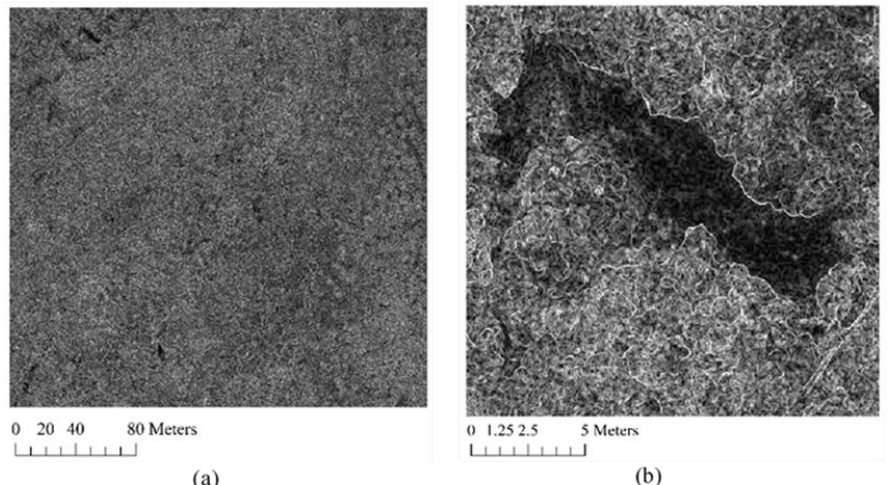
Figure 3. The edge information detected by the Roberts operator of study area I: ( a ) global and ( b ) local.